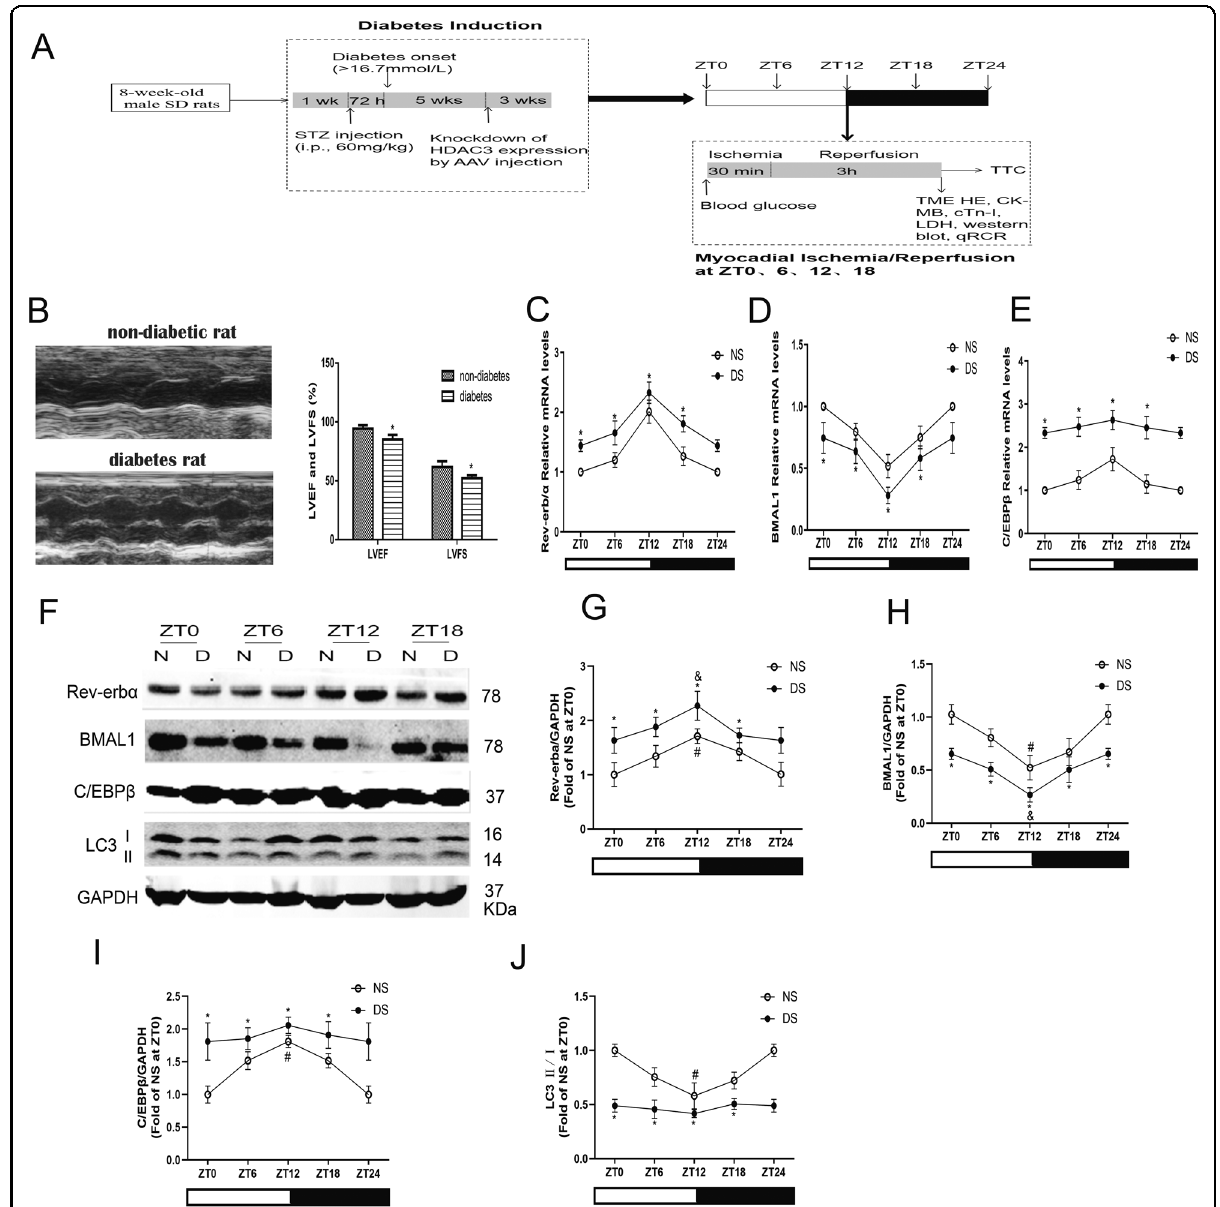
Fig. 1 Circadian clock gene rhythmicity was altered with attenuated autophagy in the hearts from STZ-induced diabetic rats. A Schematic diagram of experimental programme. B Cardiac function was assessed by echocardiography in non-diabetic and diabetic rats. Scale bar: 2 mm. C – E Expression levels of Rev-erb α ( C ), BMAL1 ( D ), and C/EBP β ( E ) mRNA were measured by qPCR over time after reperfusion. F – J The protein levels of Rev-erb α ( G ), BMAL1 ( H ), C/EBP β ( I ) and LC3 II/I ( J ) were detected by western blotting in the myocardial tissues of non-diabetes and diabetes. n = 6 per group. * P < 0.05 versus NS within ZT; # P < 0.05 versus ZT0 within NS; & P < 0.05 versus ZT0 within